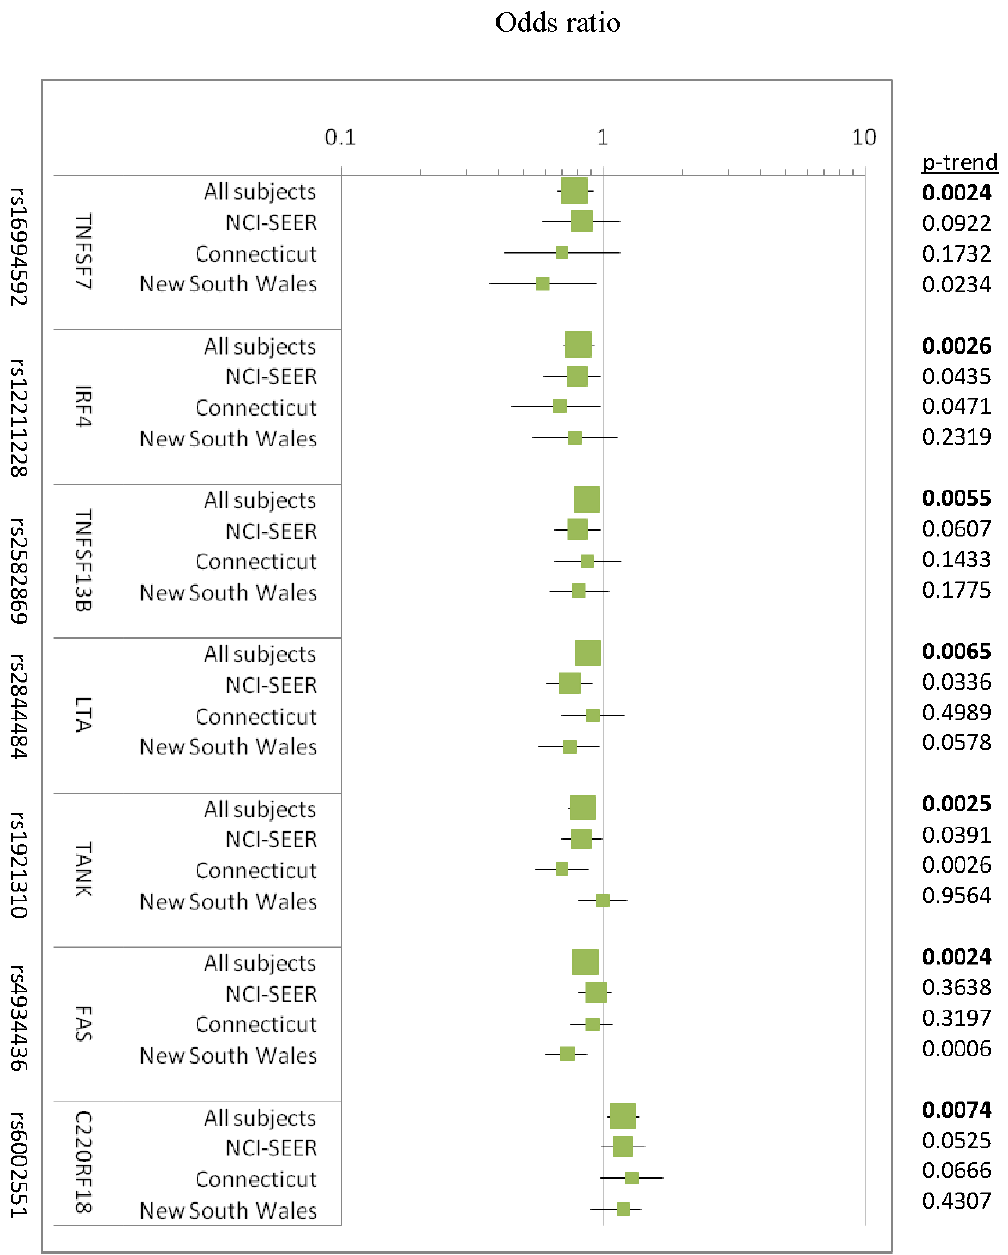
Figure 1. Odds ratios, 95% confidence intervals of additive model for SNPs with p-trends , 0.01 for NHL in pooled analyses; data also shown by study (adjusted for age, sex, race, and study site, when applicable). Data for all SNPs (pooled and by study) are shown in Supplemental Materials (Table S5).